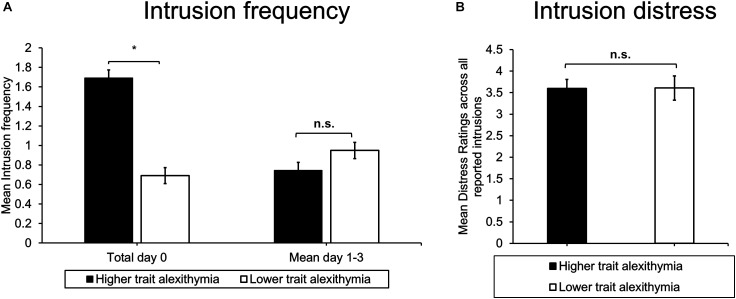
Ambulatory (A) intrusion frequency and (B) mean intrusion distress ratings for higher and lower trait alexithymia (LTA) subgroups. Error bars represent standard error of the mean, ∗indicates p < 0.05.